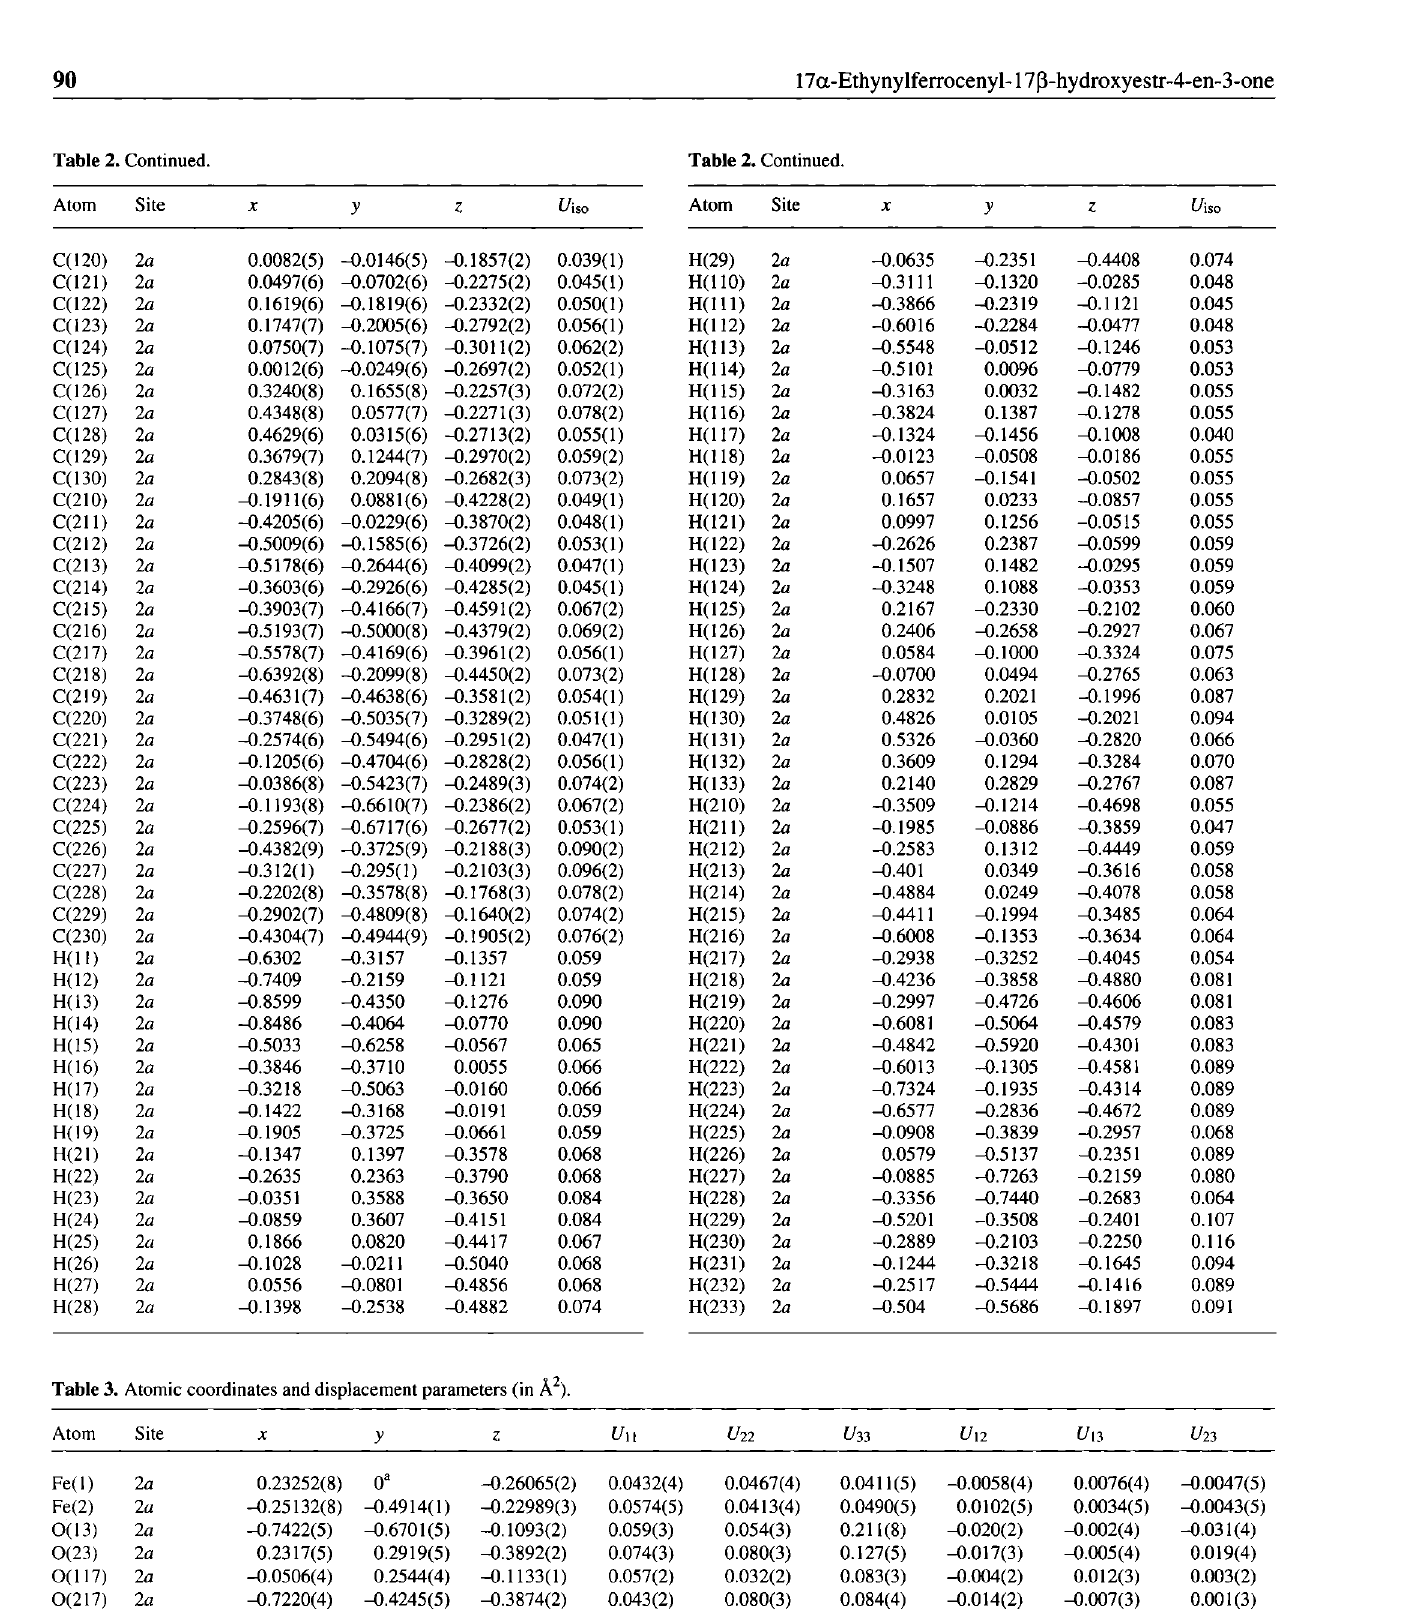
Table 3. Atomic coordinates and displacement parameters (in Ä 2